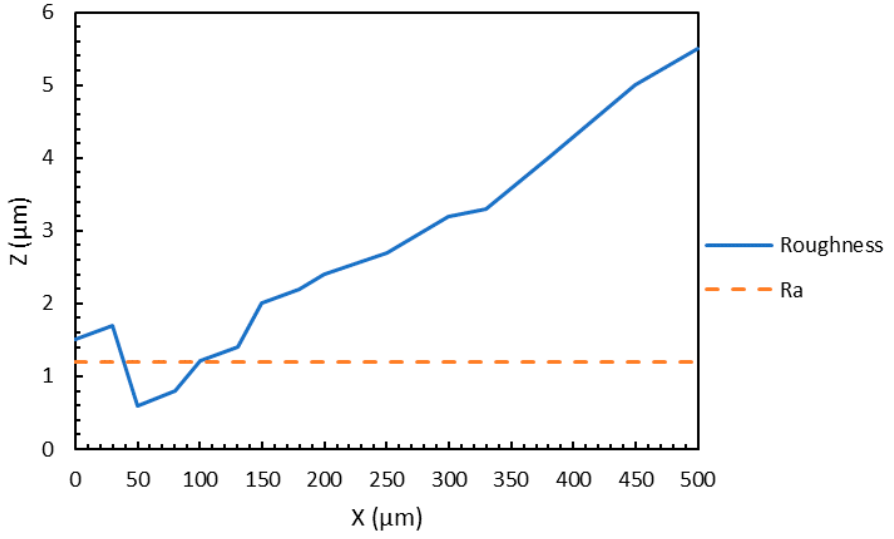
Figure 8. Sample measurement for surface roughness.